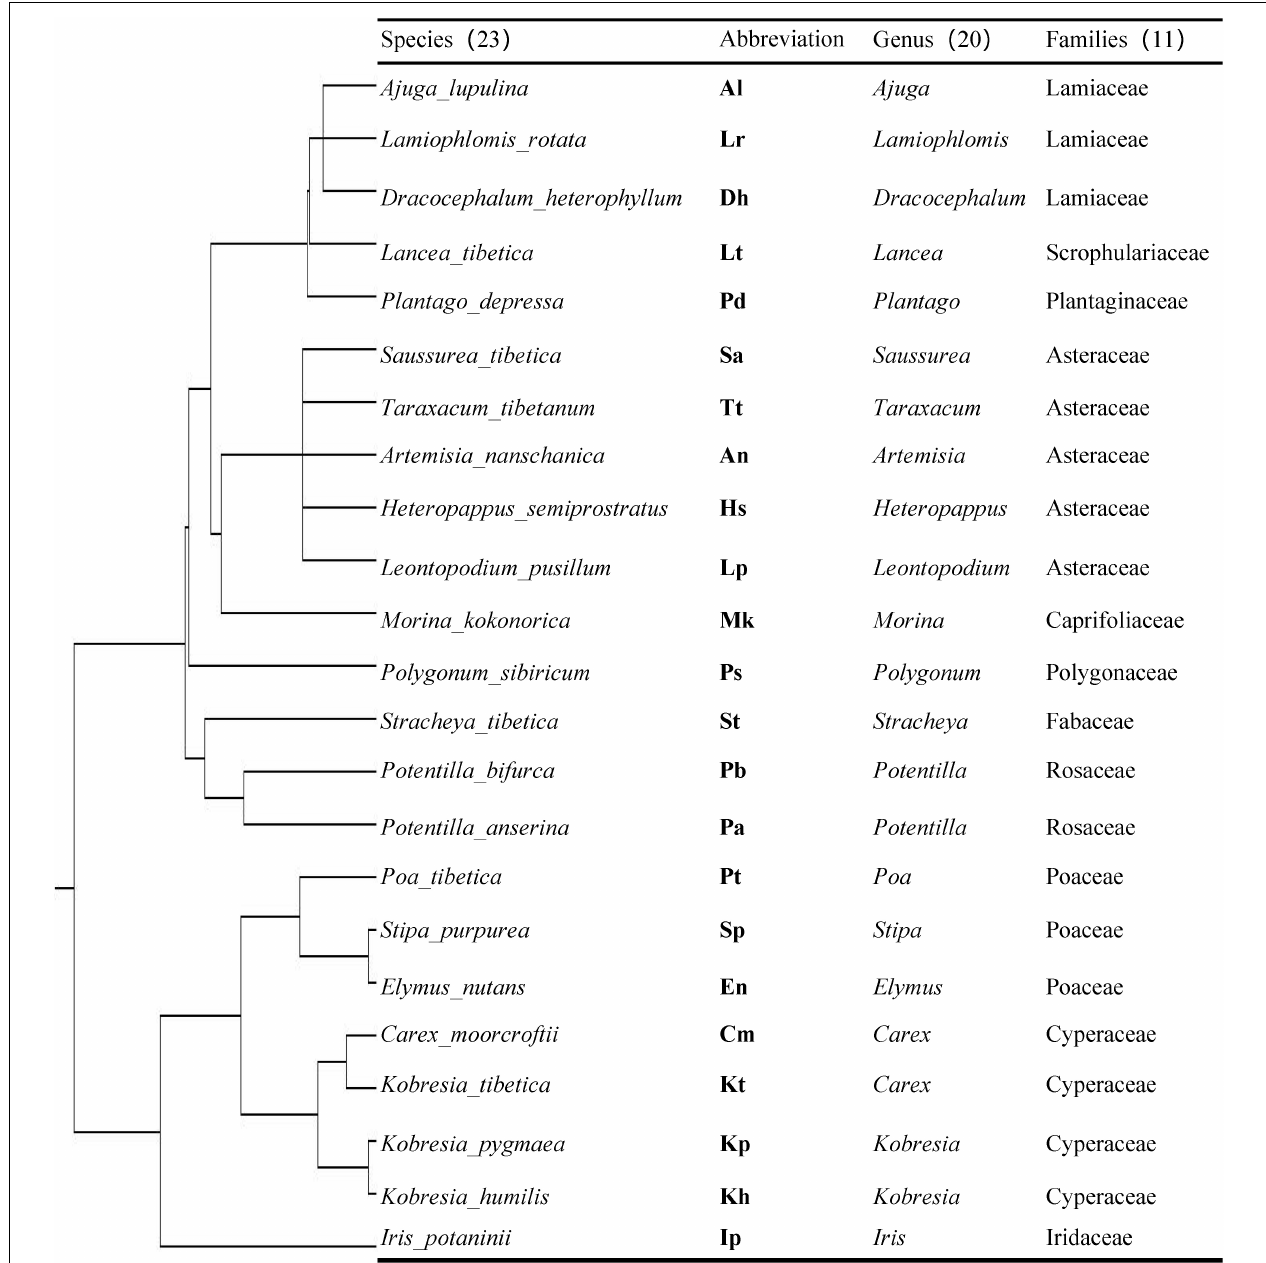
FIGURE 1 | Phylogenetic tree of 23 plants species constructed using Phylomatic. The detailed information of the 23 plant species is shown including their abbreviation, genus, and families.